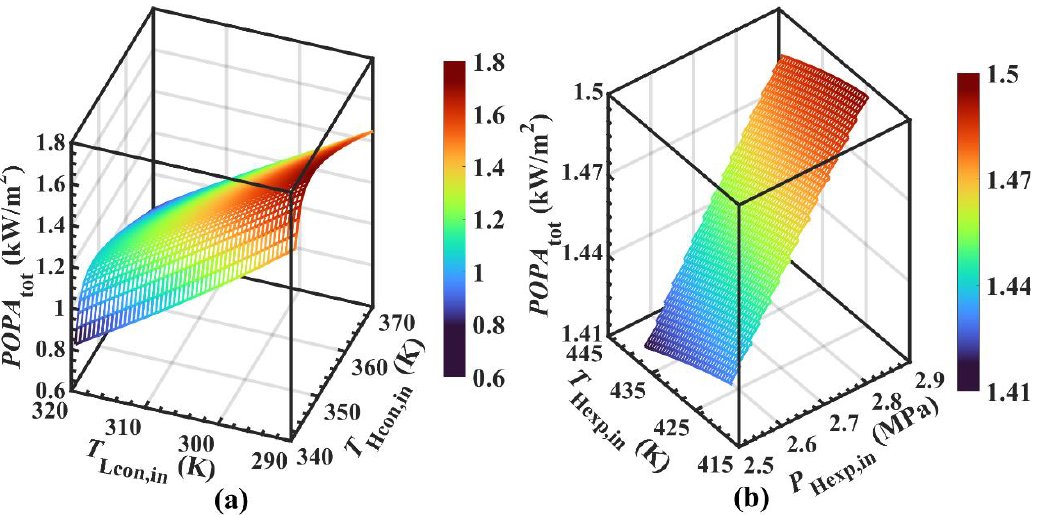
Figure 13. Influence characteristics of key variables on POPA. (a) Effect characteristics of total POPA in condenser parameter. (b) Effect characteristics of total POPA in expander parameter.